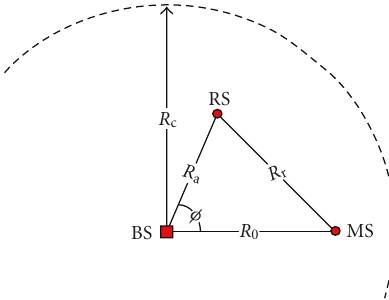
Figure 3: Illustration of opportunistic relay selection in 2D